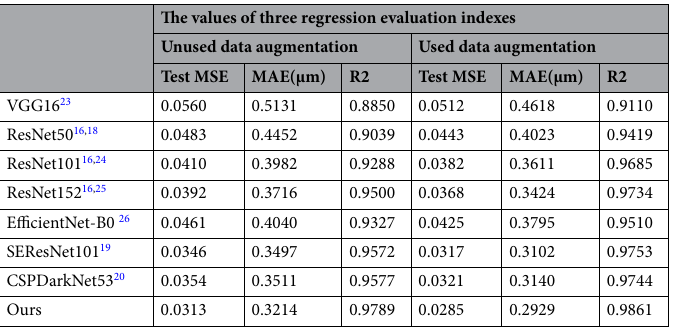
Table 5. Experimental results of “optical image-surface roughness” regression models.